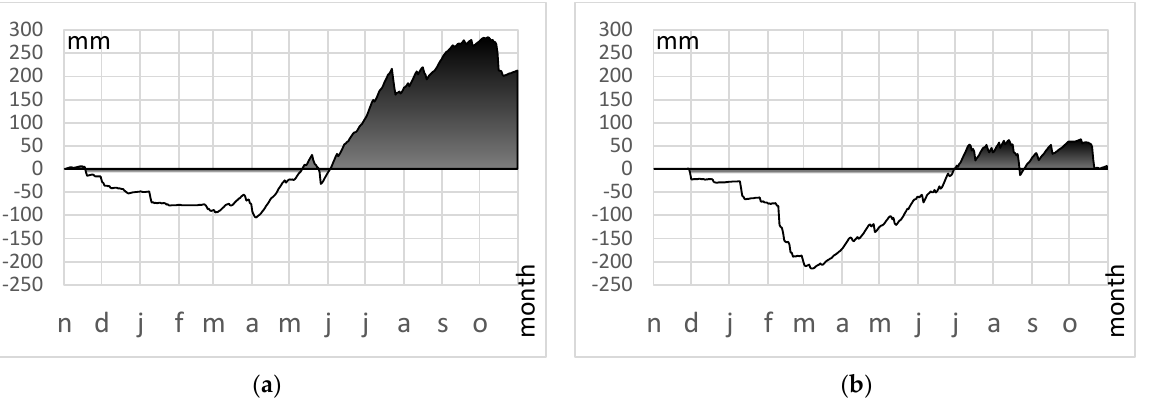
Figure 3. Cumulative values of the water deficit (mm) according to the CII in HY 2015 ( a ) and in HY 2016 ( b ). Positive values represent water deficits, and negative values represent water surpluses. Table 5. Sum of the occurrences of days with water deficiencies during the hydrological years 2015 and 2016.